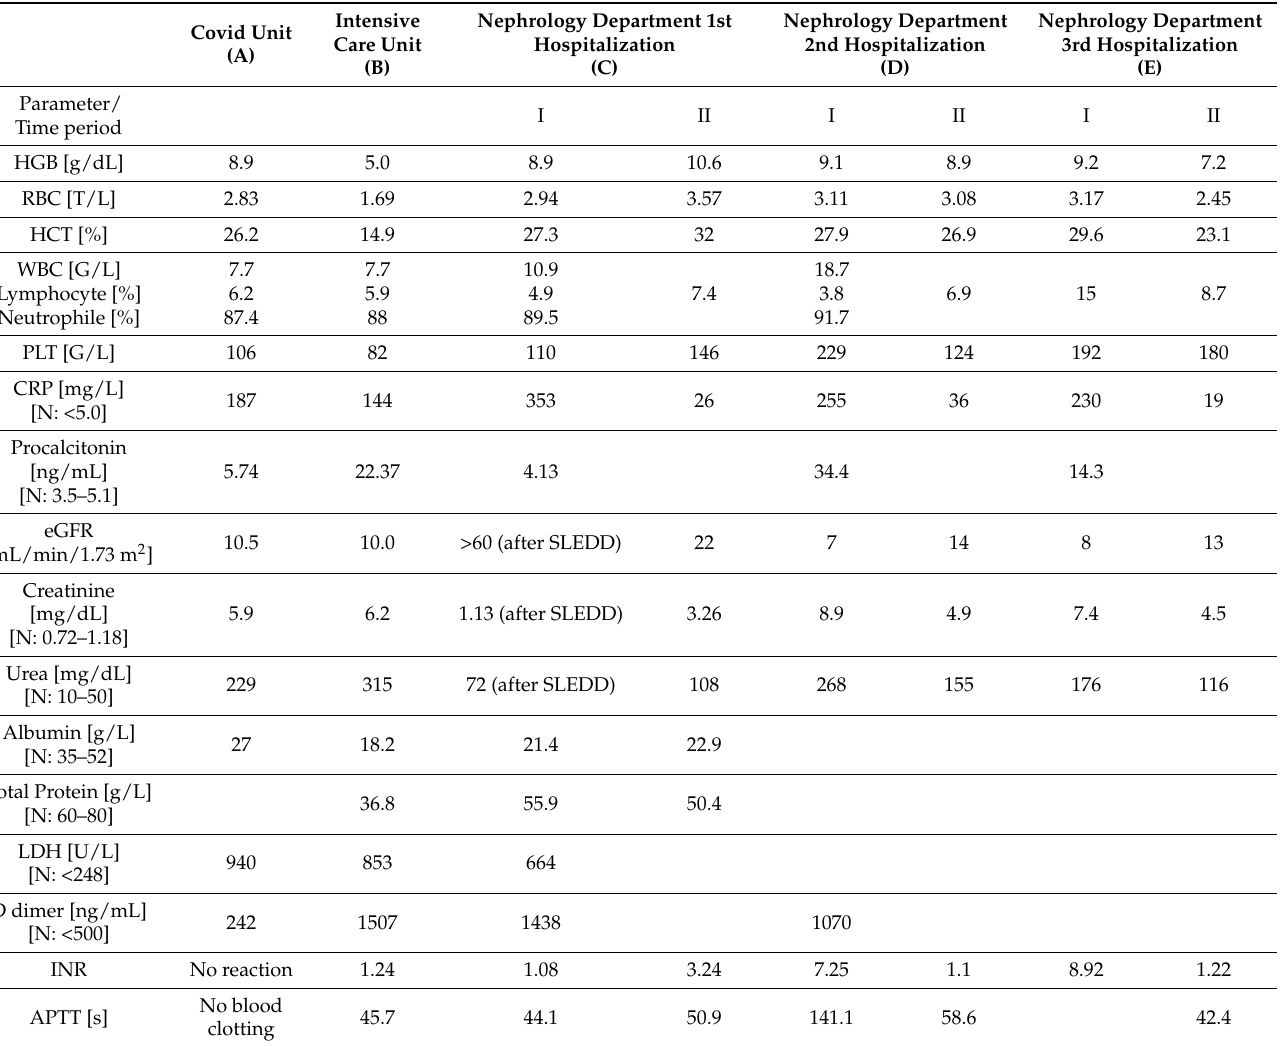
Table 1. The laboratory results during hospitalizations in: covid unit (A), intensive care unit (B), and nephrology department (C, D, and